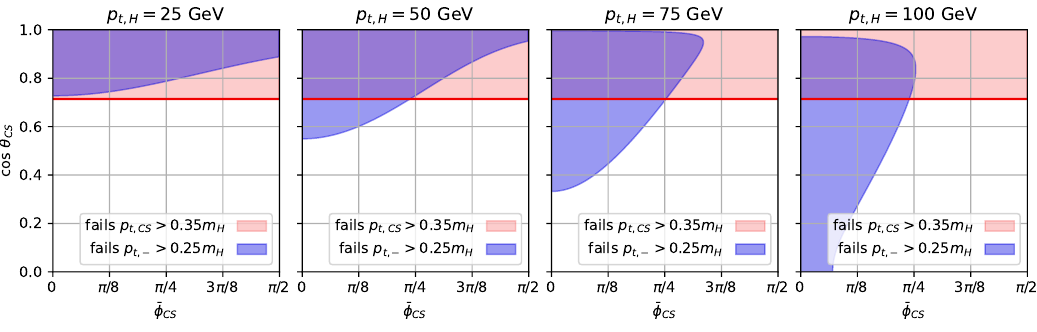
Figure 10 . Action of the p t, cs and p t, − cuts of section 3.5 in the ¯ φ cs – θ cs plane, as defined in eq. (5.2), for four values of p t, h